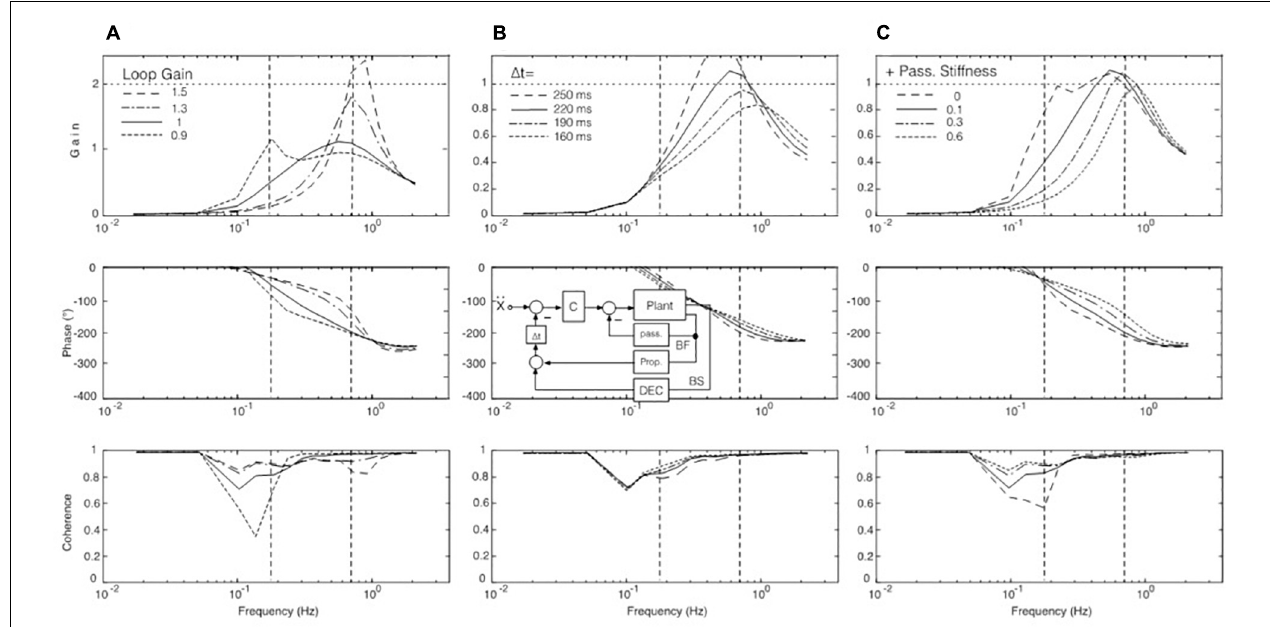
FIGURE 7 | SIP model simulations to test our hypothesis of a resonance effect. (A) Variations of loop gain. With a loop gain of unity, a peak occurs in the upper MFR (full line), but there is in addition also a tendency for a peak slightly below 0.2 Hz with reduced loop gain (dotted). Note also that the larger the peak is in the range of mid and high frequencies, the lower is the gain in the low-frequency range (by which we explain the absence of considerable sway in the low-frequency range with EC in our experiments; compare Figures 3A–C ). Other parameter changes had different effects. For example, varying instead the time delay of the feedback loops increased, respectively, decreased the amplitude of the gain peak of the FRF (panel B with inset, simplified model), while increasing selectively the gain of the passive joint stiffness shifted primarily the gain peak toward higher frequencies (C) .